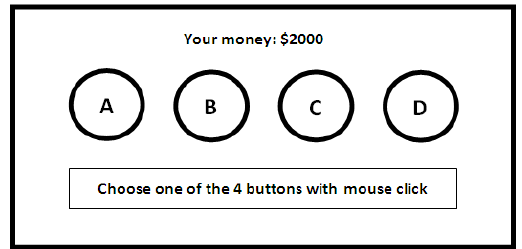
Fig. 2. Iowa Gambling Task (IGT) Fig. 3. Iowa Gambling Task (IGT) with losing and